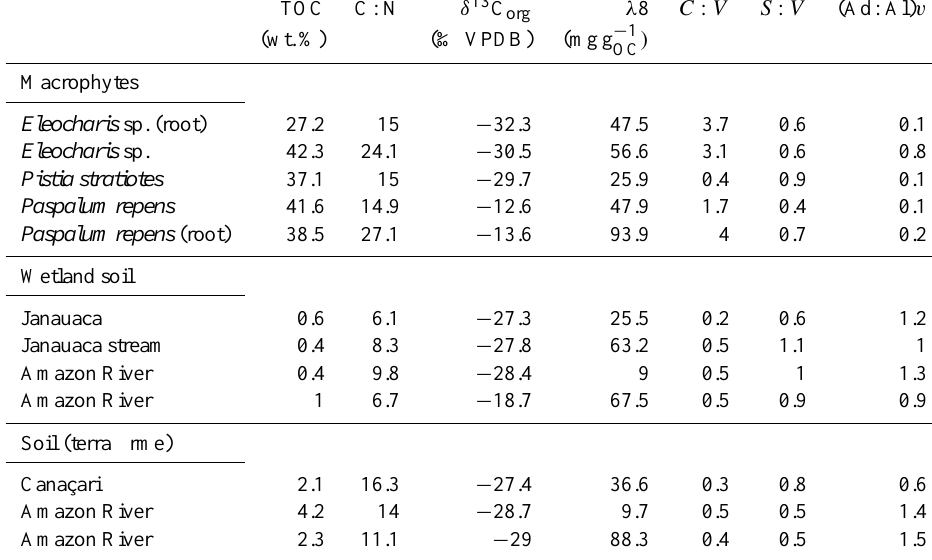
Table 2. Values of bulk parameters and lignin phenols in wetlands, terrestrial (“terra firme”) and aquatic sources of sedimentary OC. TOC C : N δ 13 C org λ 8 C : V S : V (Ad : Al) v ) (wt.%) (‰ VPDB) (mgg − 1 OC Macrophytes Eleocharis sp. (root) 27.2 15 − 32.3 47.5 0.1